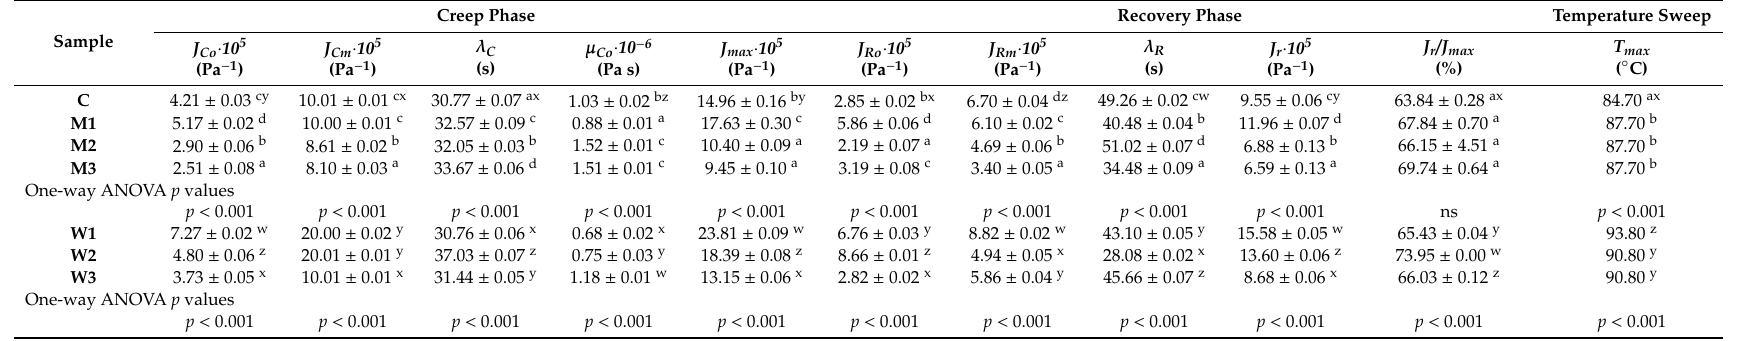
Table 2. Parameters of creep-recovery modeling, Equations (5) and (6) and gelatinization